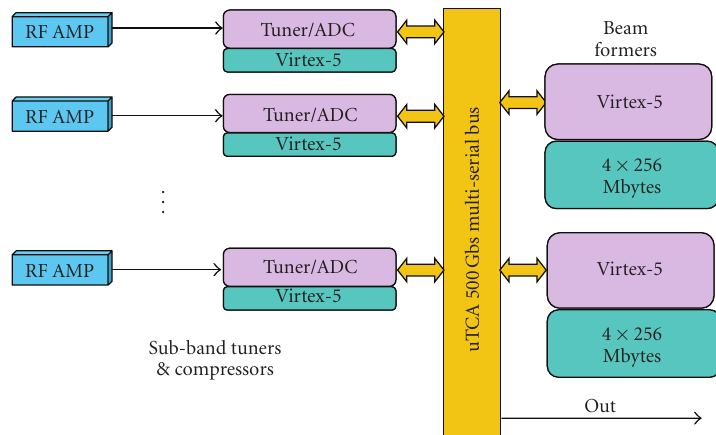
Figure 15: Multiple-Input Multiple-Output (MIMO) architecture for Virtex-5 FPGA-based